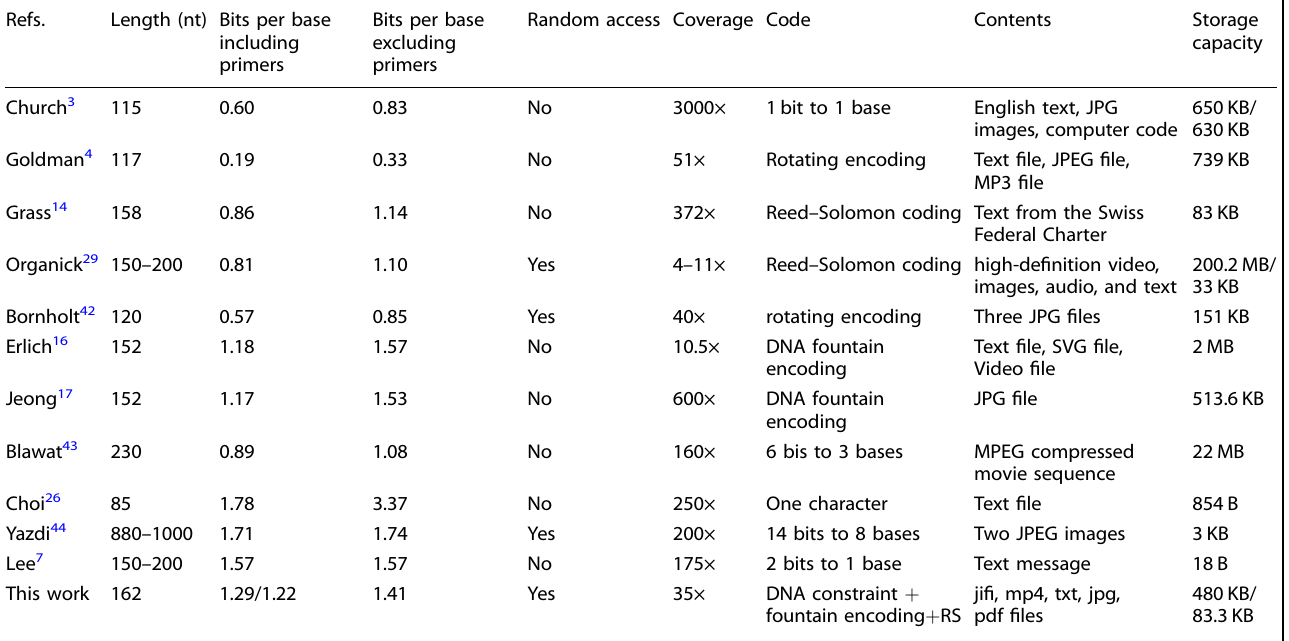
Table 4. Comparison of an adaptive coding DNA storage system with previous work.